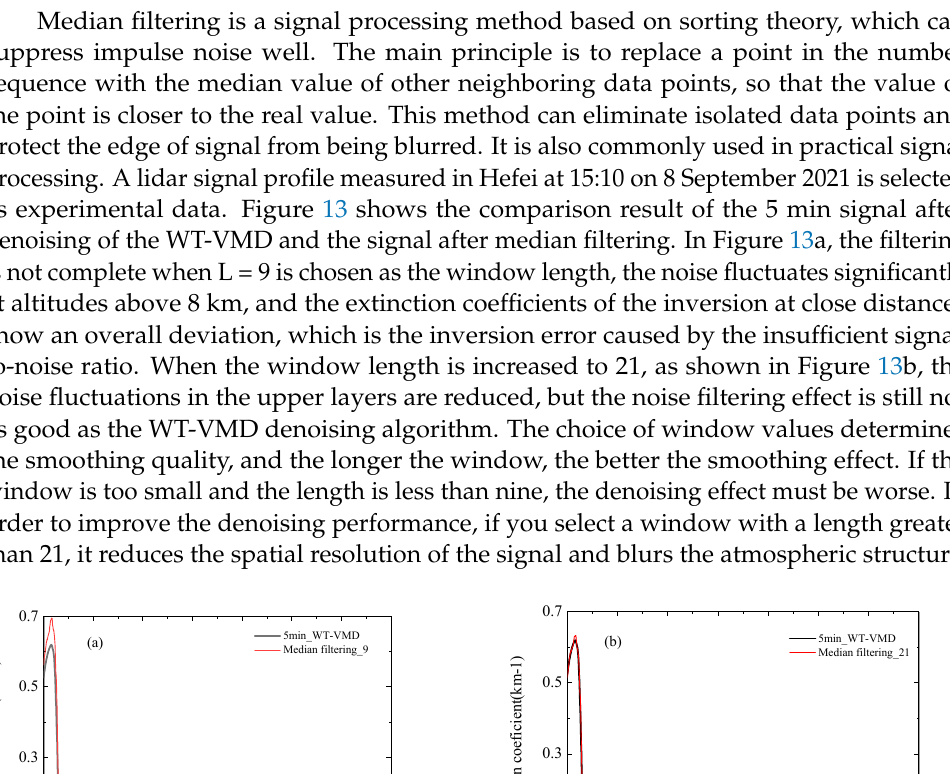
Figure 12. Comparison of extinction coefficient between averaging method and WT-VMD method ( a ) 1 h averaging vs. 5 min WT-VMD denoising; ( b ) 1 h averaging vs. 1 h WT-VMD denoising.